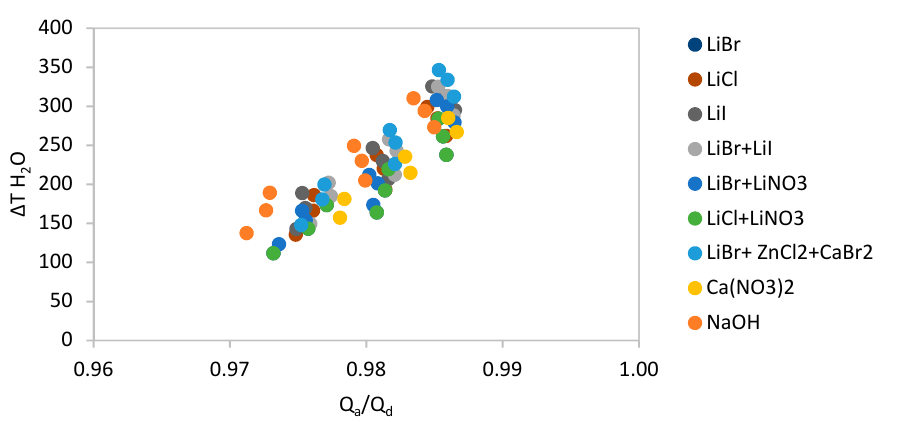
◦ C, T ◦ C and T = 13, 14, 15 ◦ a = 8, 9, 10 d